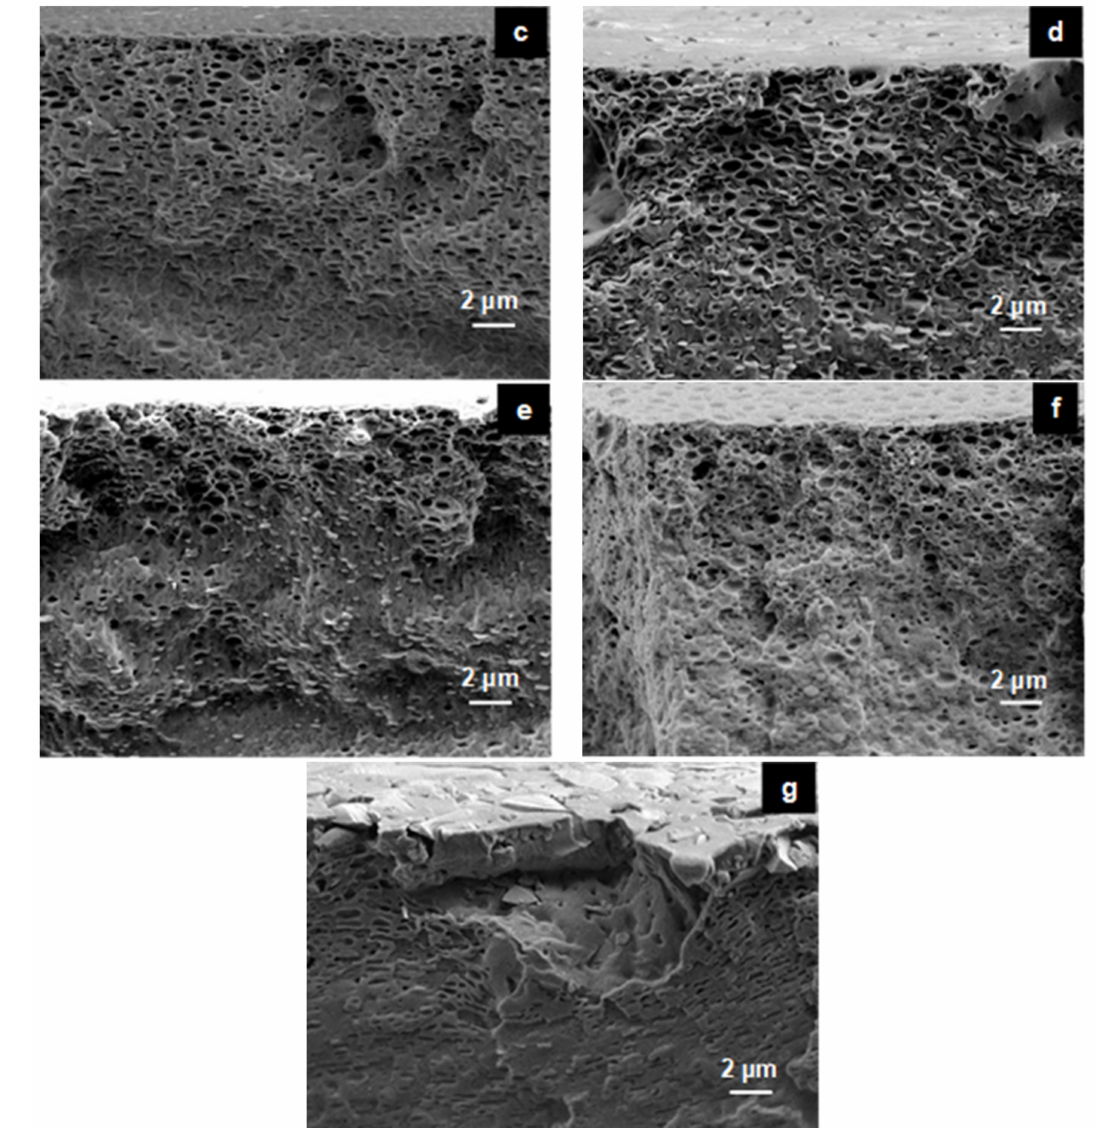
Figure 8. FESEM micrographs of the cross-sectional views of the ( a ) NMPC/PVA-SiO 2 (0.5 wt.%), ( b ) NMPC/PVA-SiO 2 (1 wt.%), ( c ) NMPC/PVA-SiO 2 (2 wt.%), ( d ) NMPC/PVA-SiO 2 (4 wt.%), ( e ) NMPC/PVA-SiO 2 (6 wt.%), ( f ) NMPC/PVA- SiO 2 (8 wt.%), and ( g ) NMPC/PVA-SiO 2 (10 wt.%) composite